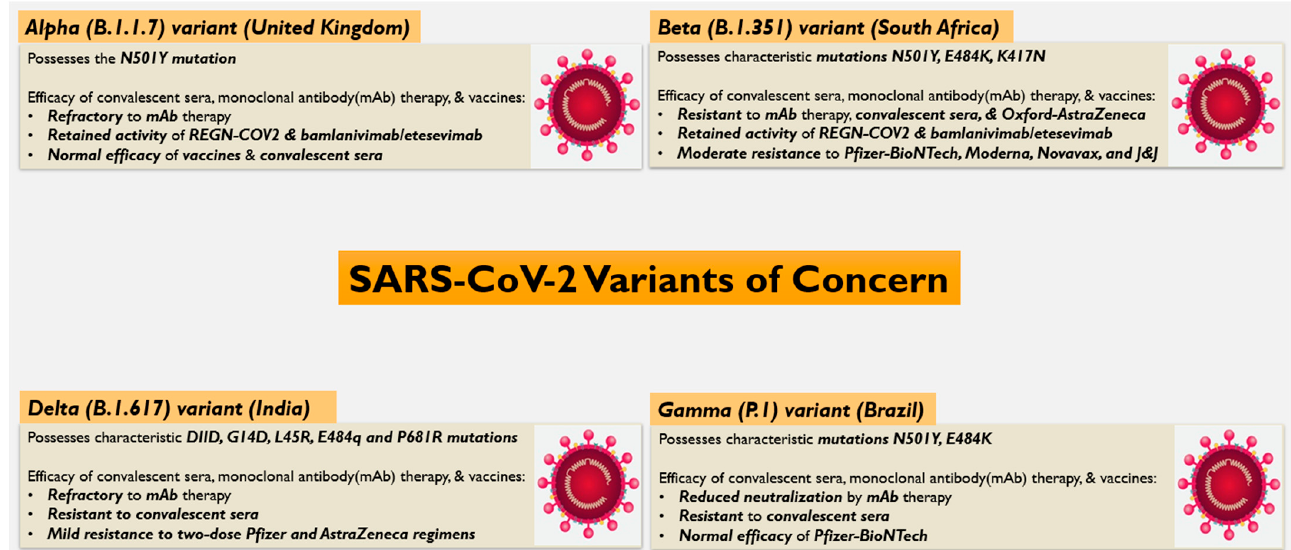
Figure 1. Variants of Concern (VOC): This figure shows the characteristics features of the four major VOCs of SARS-CoV-2: Alpha (United Kingdom), Beta (South Africa), Gamma (Brazil), and Delta (India).